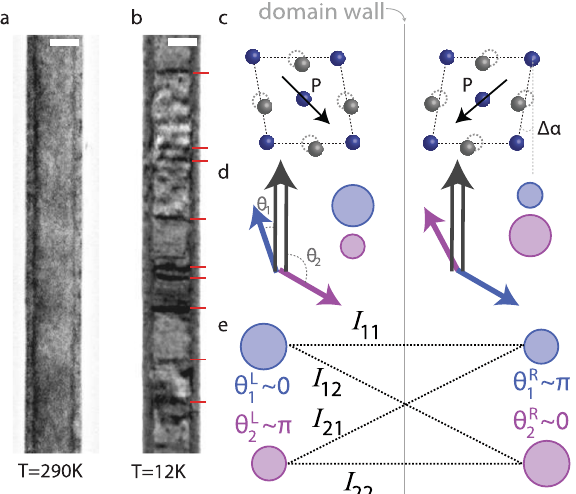
Fig. 4 Effect of ferroelectric distortion on proximity effect and Josephson current. a – b TEM images of a SnTe nanowire at T = 290 K and T = 12 K, respectively. The scale bar in the upper right corner of each image is 50 nm. Dark bands perpendicular to the growth direction, indicated by red lines in b , are domain walls separating different polarization directions. Scale bars in the upper right corner of each image are 50 nm. c The cubic lattice at room temperature undergoes a transition to a rhombohedral lattice at T = 80 K with two domains. d Unequal phase angles for the two ferroelectric domains. e The four-channel supercurrent fl ow across a domain wall. The two interband channels I ij behave like conventional "0"- junctions, whereas the intraband channels I ii behave like " π "-